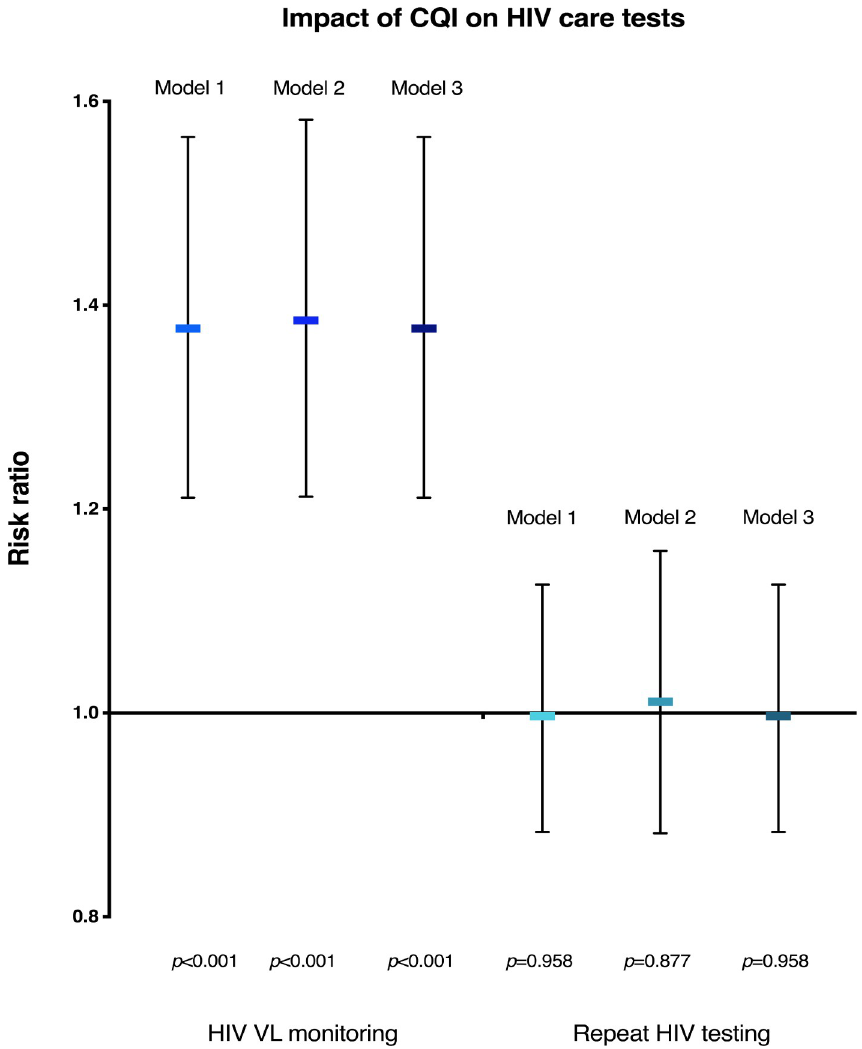
Fig 4. Effects of CQI on VL monitoring and repeat HIV testing. Model 1 includes time-step fixed effects and clinic random effects. Model 2 includes time-step fixed effects, clinic random effects, and a random clinic–time step interaction term. Model 3 includes time-step fixed effects, clinic random effects, and individual random effects. CQI, continuous quality improvement; VL, HIV viral load